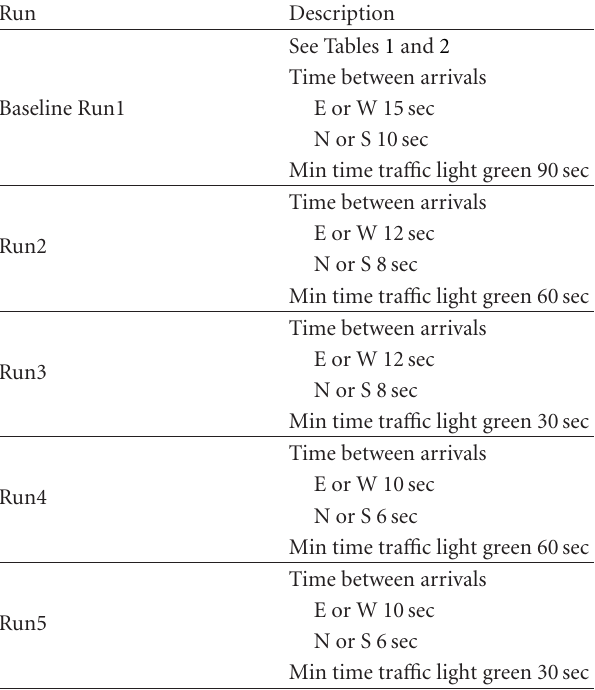
Table 2: Input data for Baseline Run1 dummy activities.